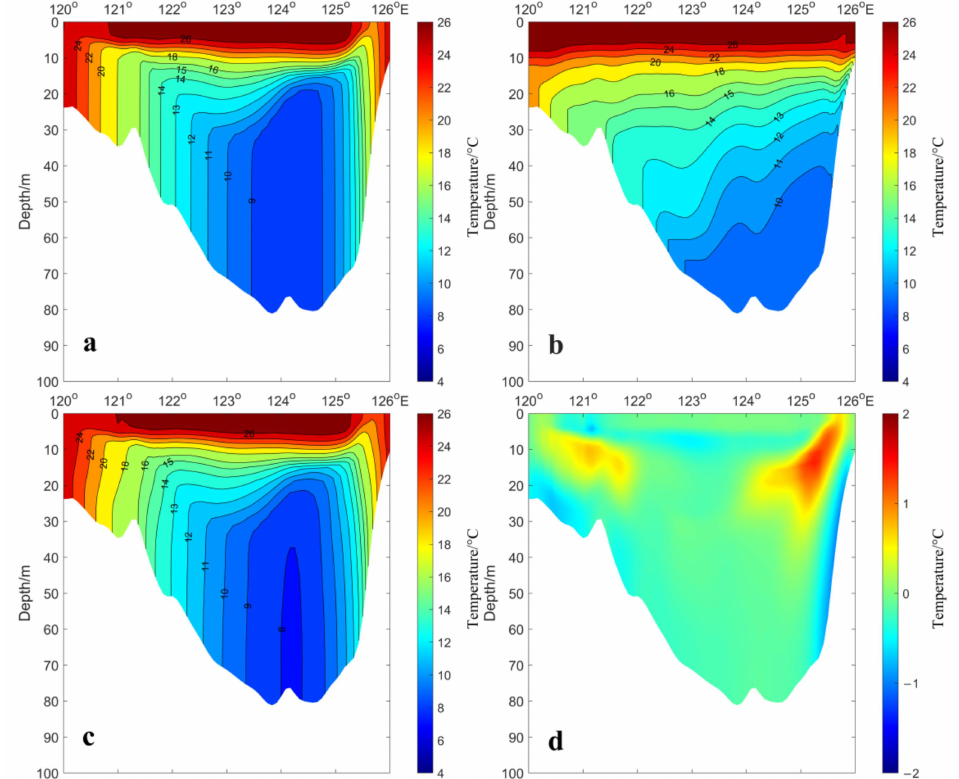
Figure 9. Modeled vertical temperature structures [19] along 35 ◦ N in August for Experiment 1 ( a ), Experiment 2 ( b ), and Experiment 3 ( c ). ( d ) Differences of modeled water temperature between Experiment 3 and Experiment